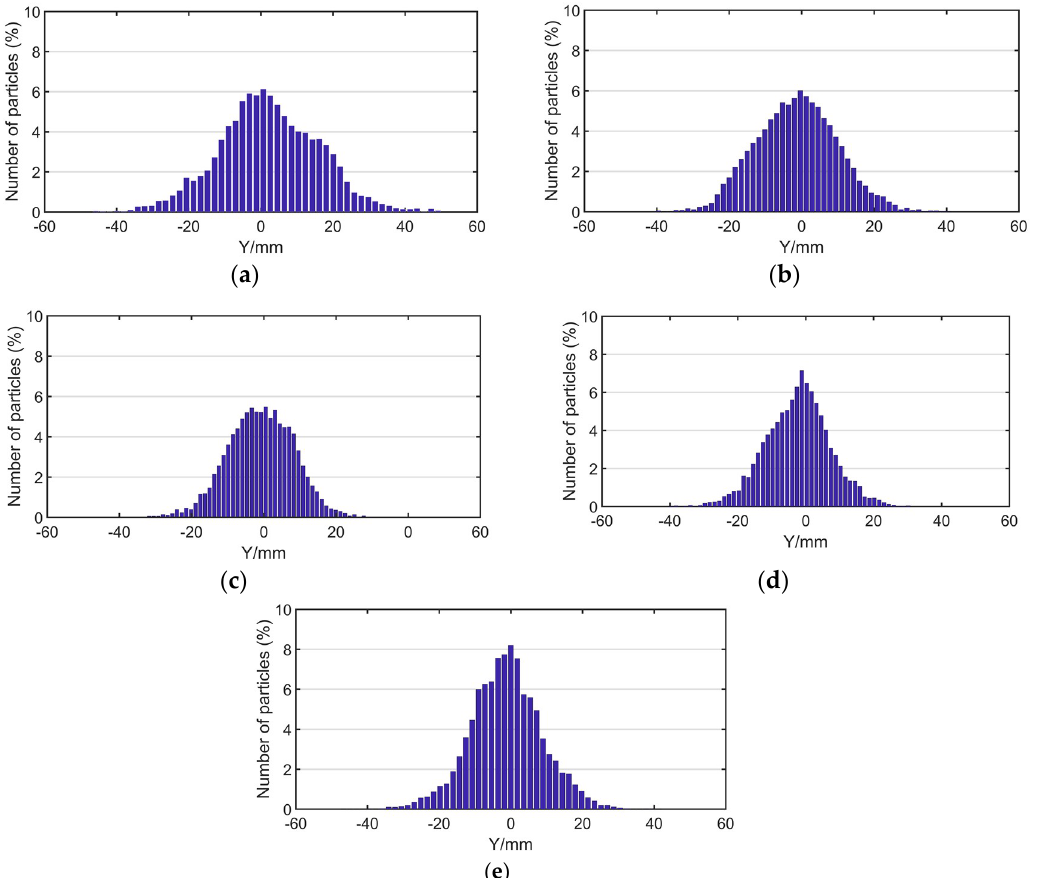
Figure 14. Under different Δ, the number distribution of particles along the y -axis on the target Figure 14. Under di ff erent ∆ , the number distribution of particles along the y -axis on the target surface: surface: ( a ) Δ = 4.3; ( b ) Δ = 5.8; ( c ) Δ = 7.3; ( d ) Δ = 8.8; ( e ) Δ = 10.3. ( a ) ∆ = 4.3; ( b ) ∆ = 5.8; ( c ) ∆ = 7.3; ( d ) ∆ = 8.8; ( e ) ∆ =